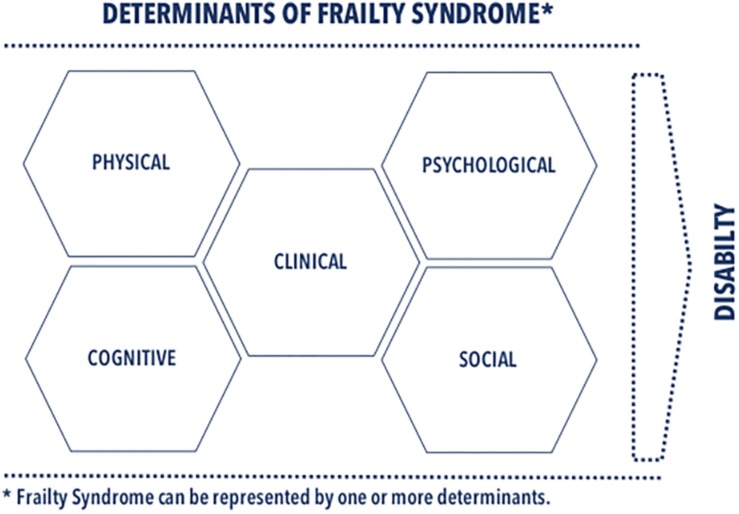
Determinants of FS.